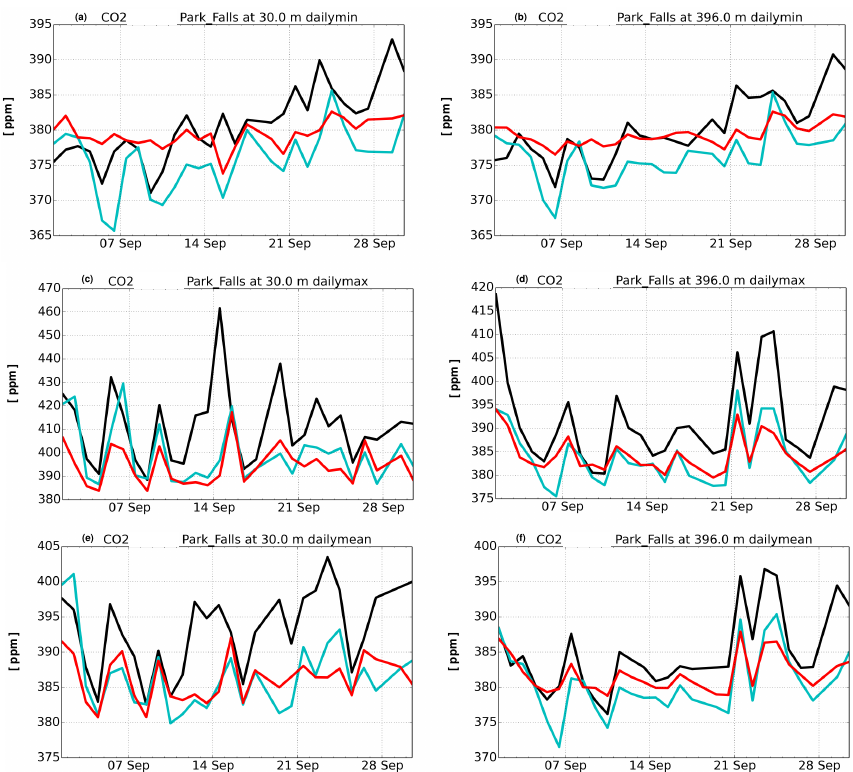
Figure 8. Daily minimum, maximum and mean atmospheric CO 2 at Park Falls (Wisconsin, USA) at 30m (left panels) and 396m (right panels) from observations in black, the hindcast with NEE synoptic variability in light blue and the simulation with monthly mean NEE in red for September